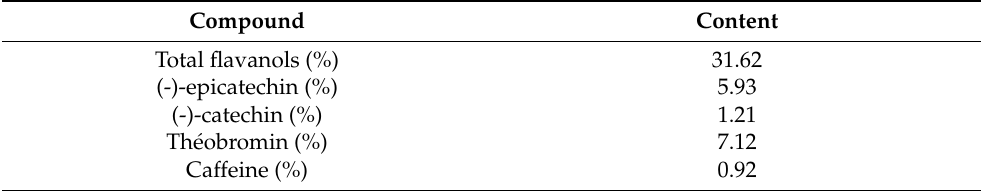
Table 1. Composition of the cocoa